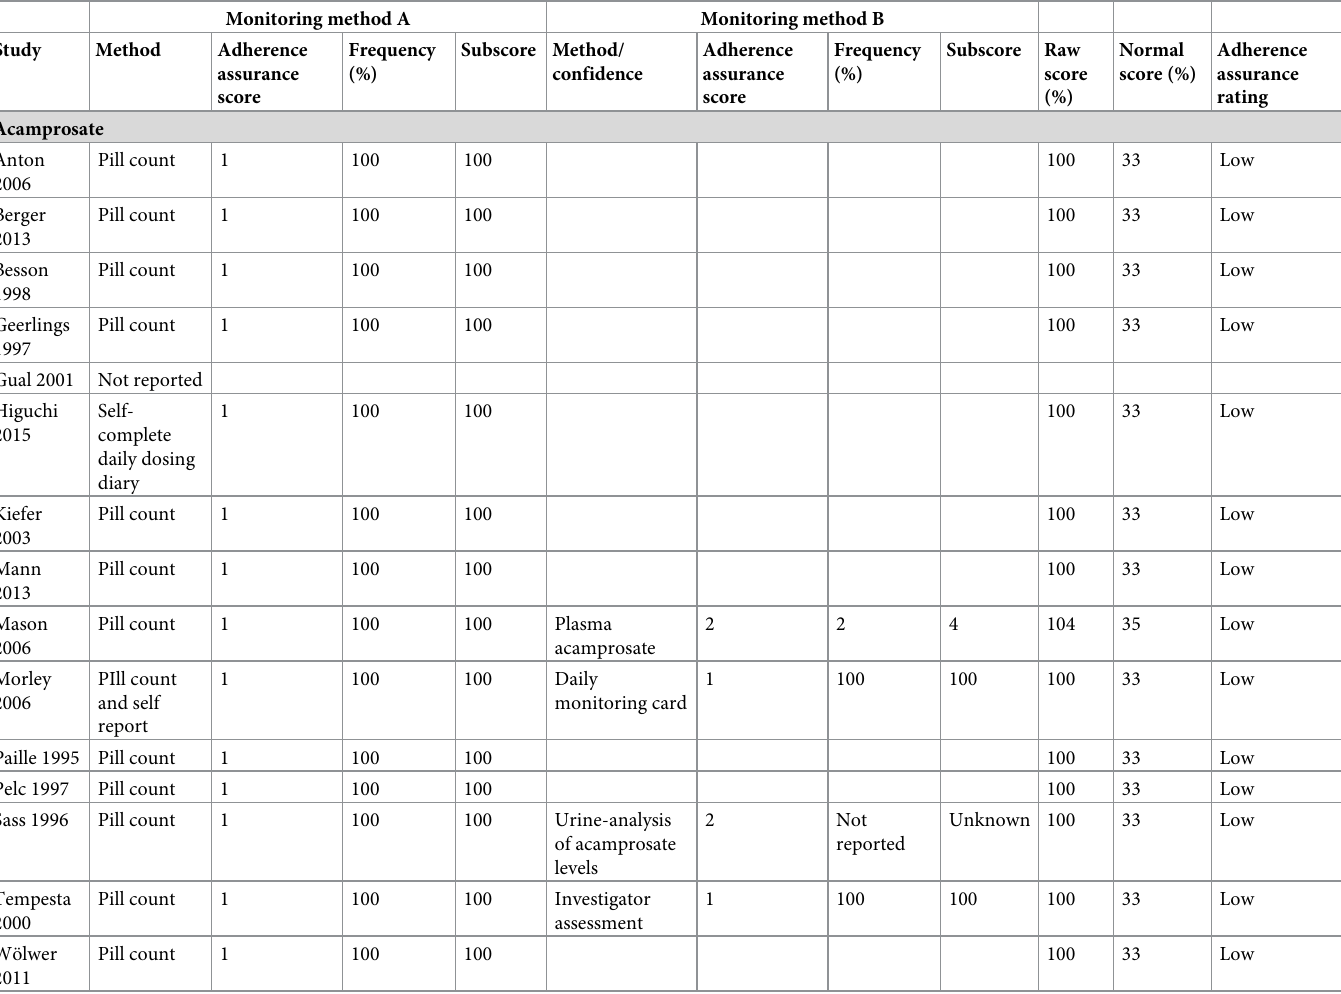
Table 2. Adherence-assurance rating for